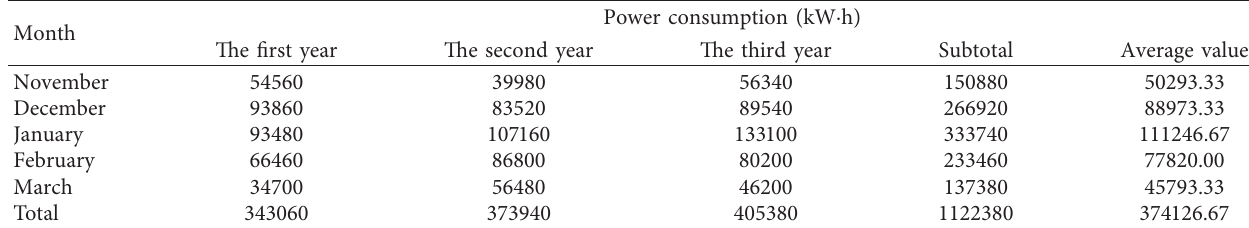
Table 6: Power consumption statistics of the system after transformation.